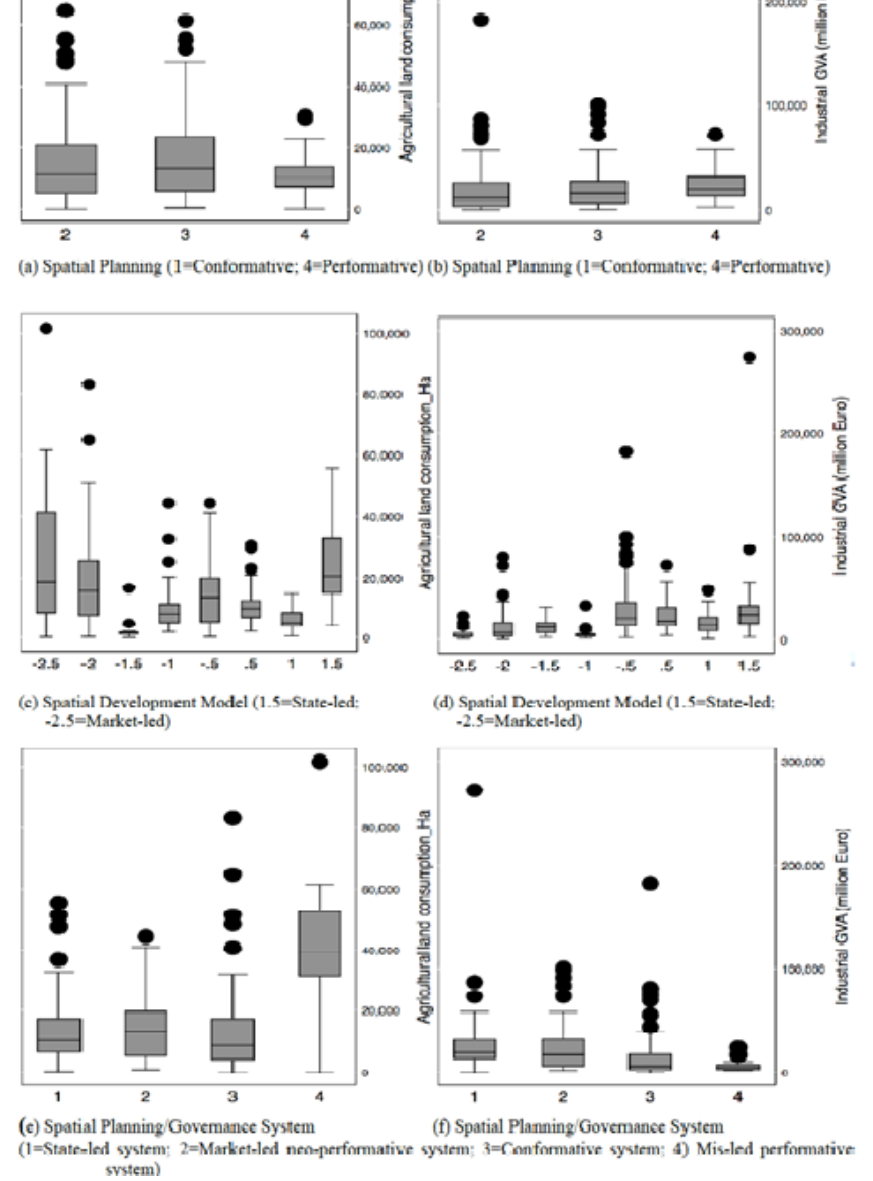
Figure 4. Box plot distribution of socio ‐ economic variables based on Europe’s spatial governance and planning system classification obtained from Berisha et al. [60]. Scheme 24 and Eurostat.